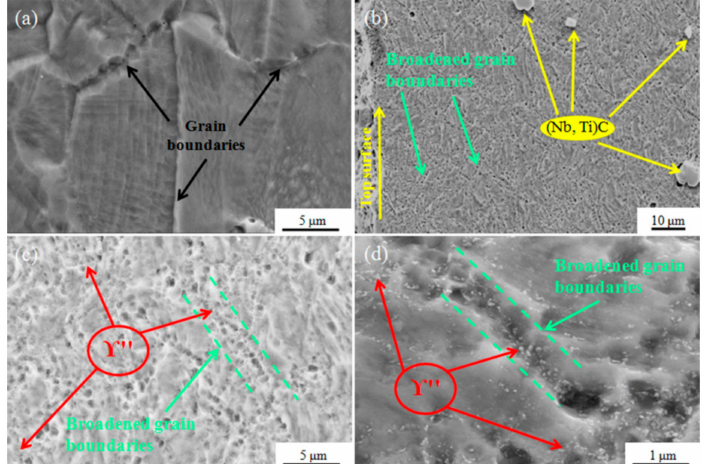
Figure 7. SEM maps of untreated and USRP-treated samples after the hot compression test at the true strain rate of 0.001 s − 1 and temperature of 700 ◦ C: ( a ) Showing the grain boundaries of the untreated sample, ( b ) Showing the broadened grain boundaries in the near-surface regions of the USRP-treated sample, ( c , d ) The precipitation of γ ” phase within broadened grain boundaries in the near-surface regions of the USRP-treated